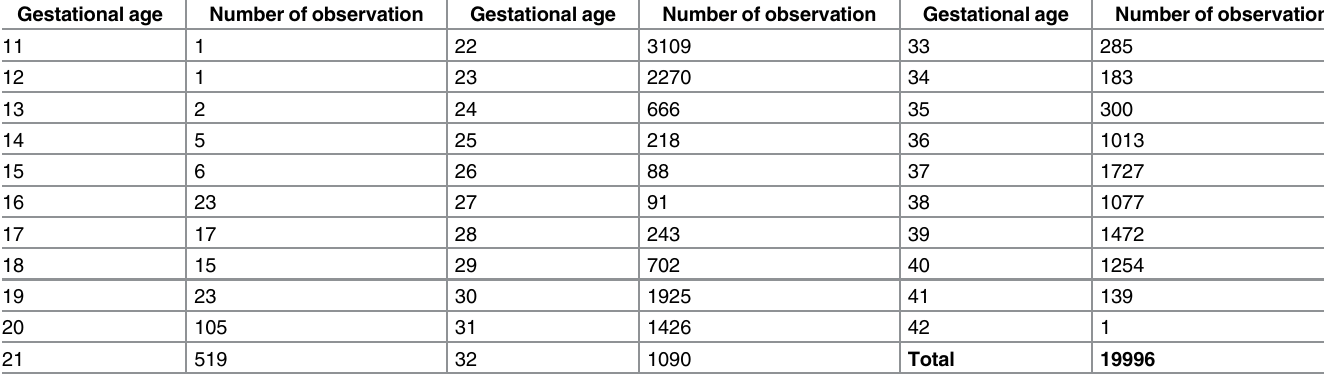
Table 3. The numbers of valid observations for femur length (FL) at each gestational week.